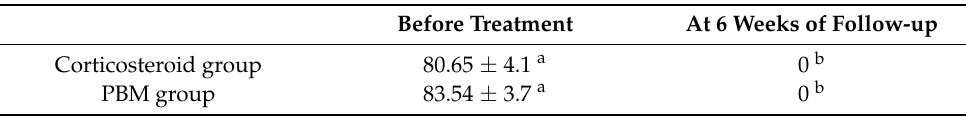
Table 3. VAS values before treatment and at 6 weeks of follow-up. 0 represented no pain at all and 10 represented the greatest pain. Similar letters indicate non-significant differences. Different letters indicate significant